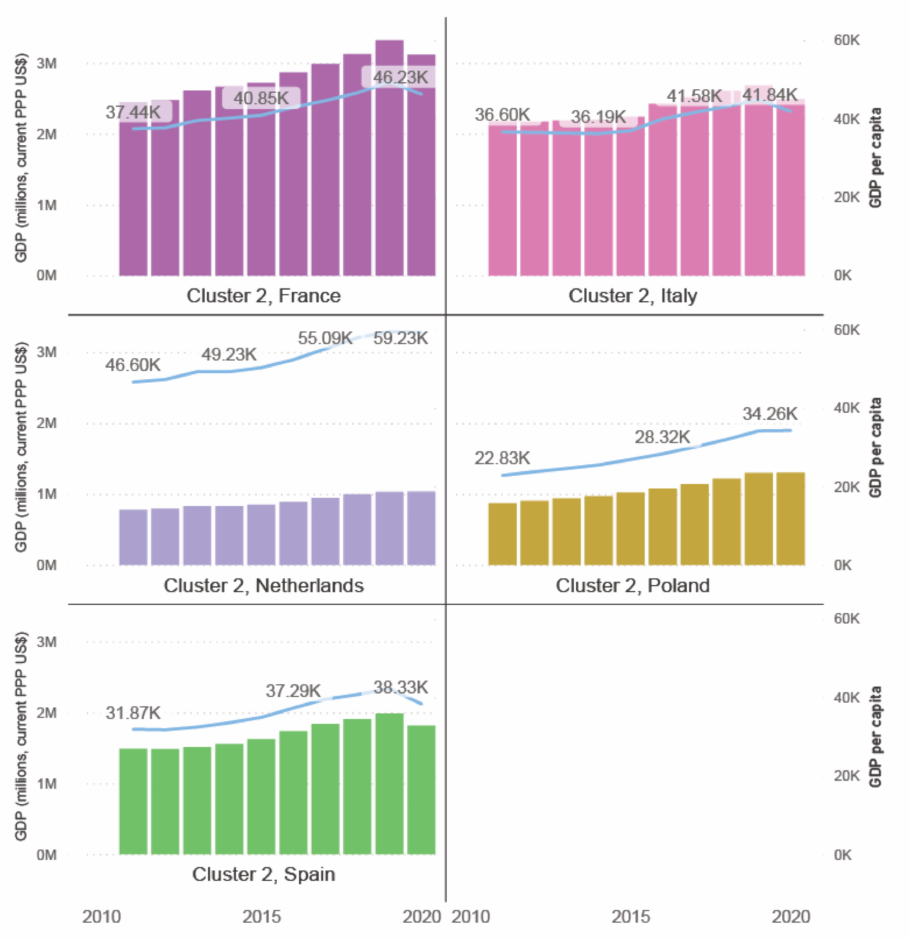
Figure 17. GDP and GDP per capita for the cluster of highly robotized countries. Source: Author’s contri- bution based on data retrieved from International Comparison Program, World Bank, World Development Indicators database, World Bank|Eurostat-OECD PPP Programme. Available at: https://data.worldbank. org/indicator/NY.GDP.PCAP.PP.CD and https://data.worldbank.org/indicator/NY.GDP.MKTP.PP.CD, accessed on 10 March